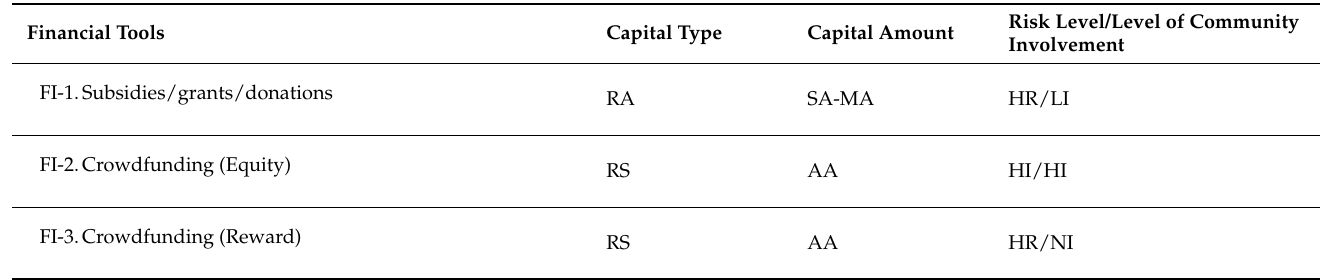
Table 3. (Alternative) financial instruments (based on